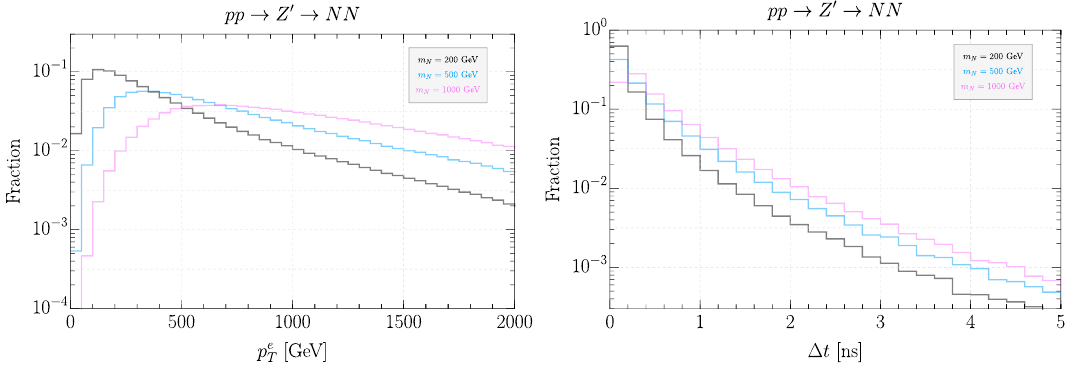
Figure 9 . Distributions of p e